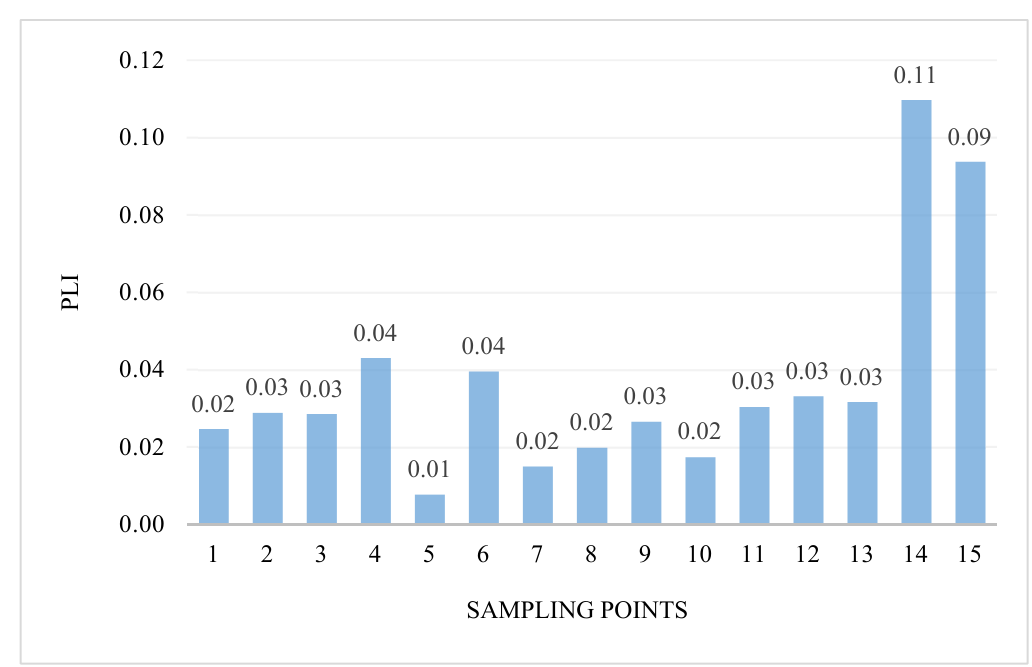
Figure 4. Value of the PLI in bottom sediments of Pisa River and its tributaries.